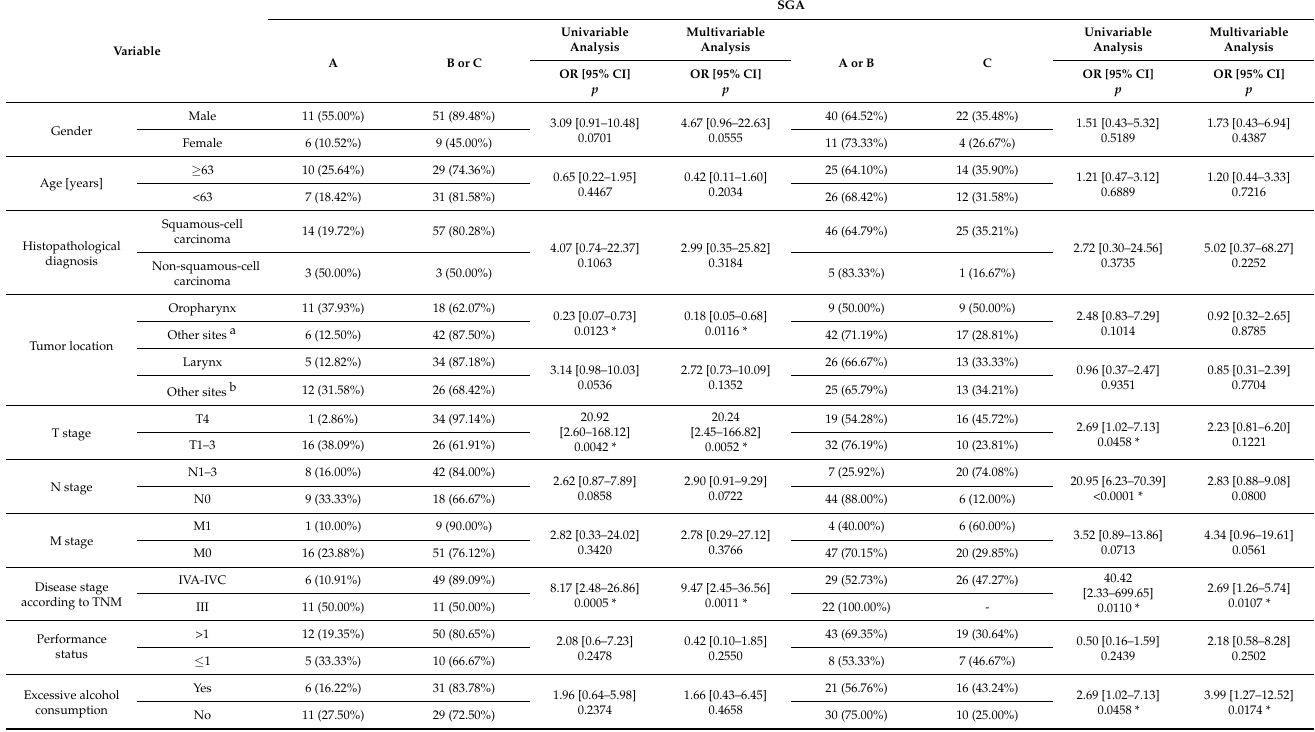
Table 2. The influence of the demographic, clinical, and genetic variables on the risk of malnutrition according to